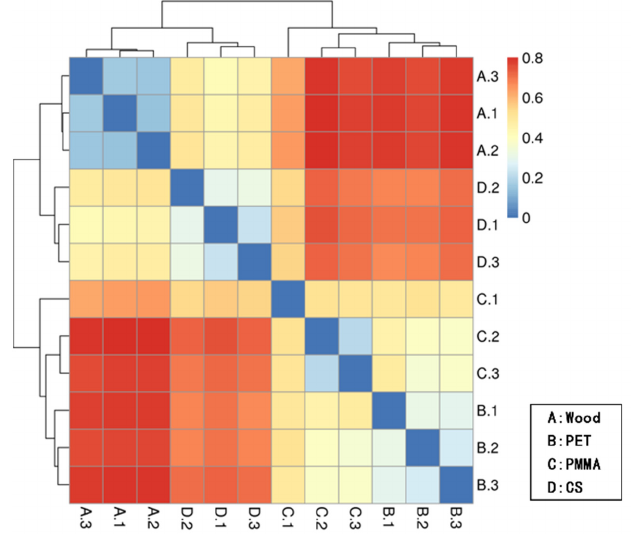
Figure 4. Heatmap of sample distance under Bray–Curtis distance formula. The bluer the color means the more similar the sample. The results confirm that the A, D and B, C have distinct differences.